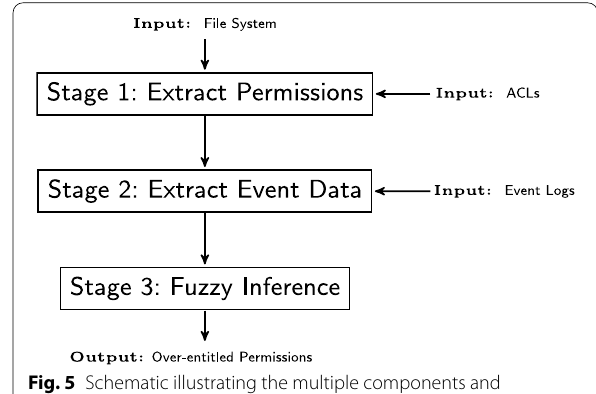
Fig. 5 Schematic illustrating the multiple components and information